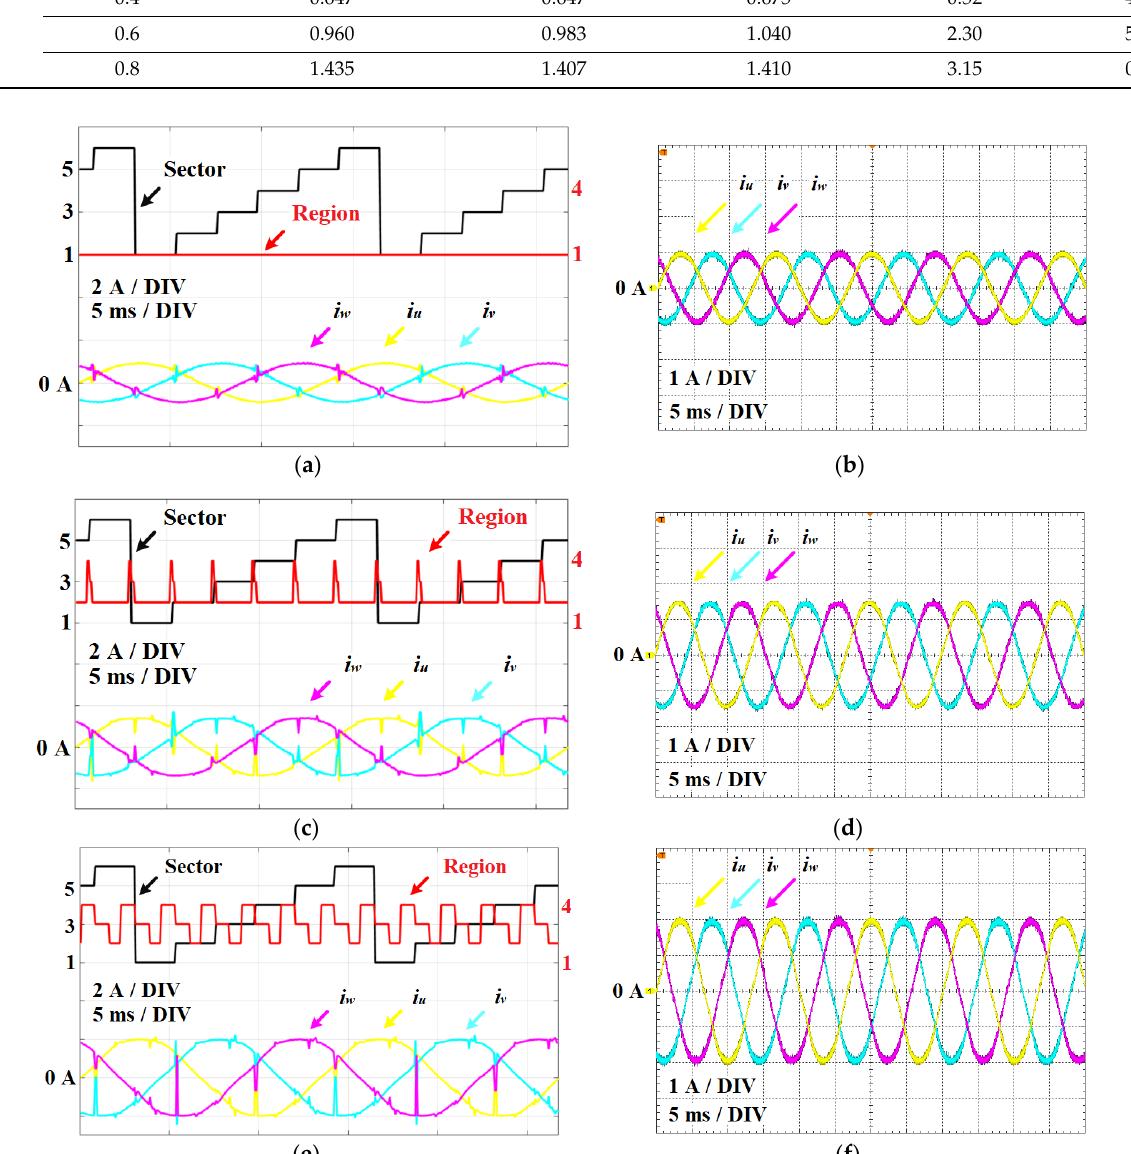
Figure 21. Single-shunt reconstruction of a three-phase current without SVM modification for f = 75 Hz: ( a ) m i = 0.4; ( c ) m i = 0.6; ( e ) m i = 0.8; scope-measured real three-phase currents for f = 75 Hz: ( b ) m i = 0.4; ( d ) m i = 0.6; ( f ) m i = 0.8.